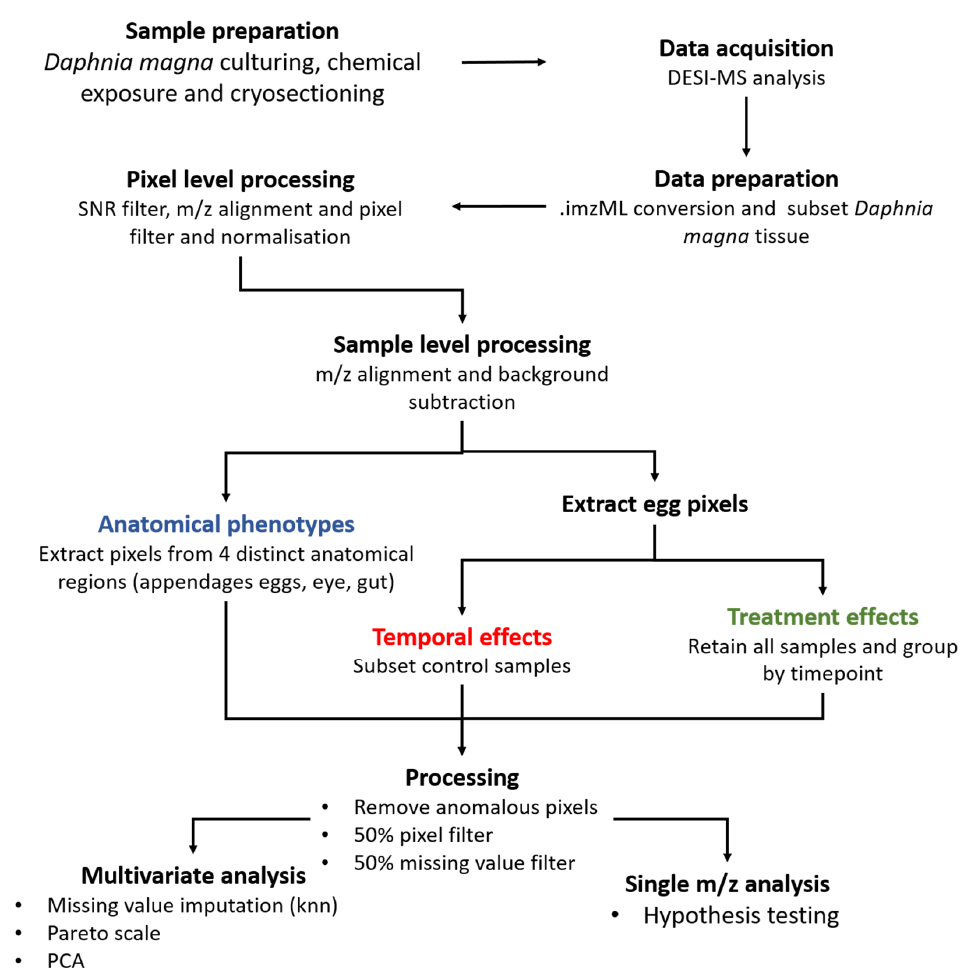
Figure 2. DESI mass spectrometry imaging workflow from culturing to statistical analysis for spatial lipidomic studies of Daphnia magna .